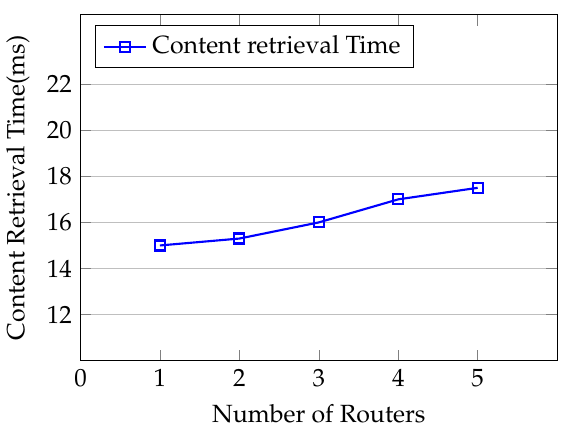
Figure 13. Content retrieval delay for n-number of